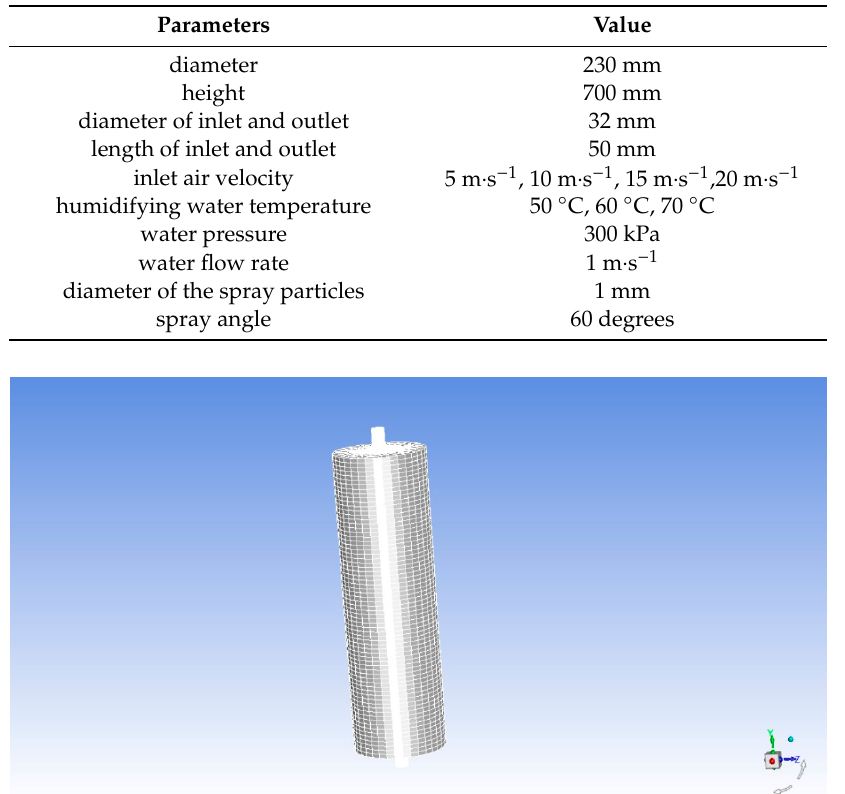
Table 1. Parameters for the model.